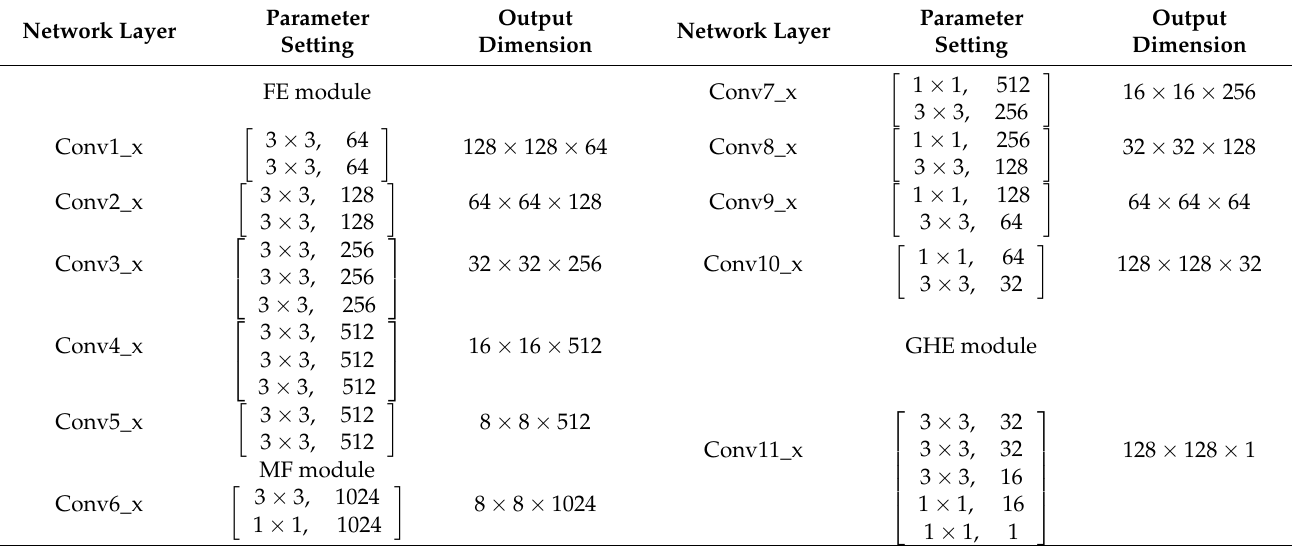
Table 1. Parameter setting of the